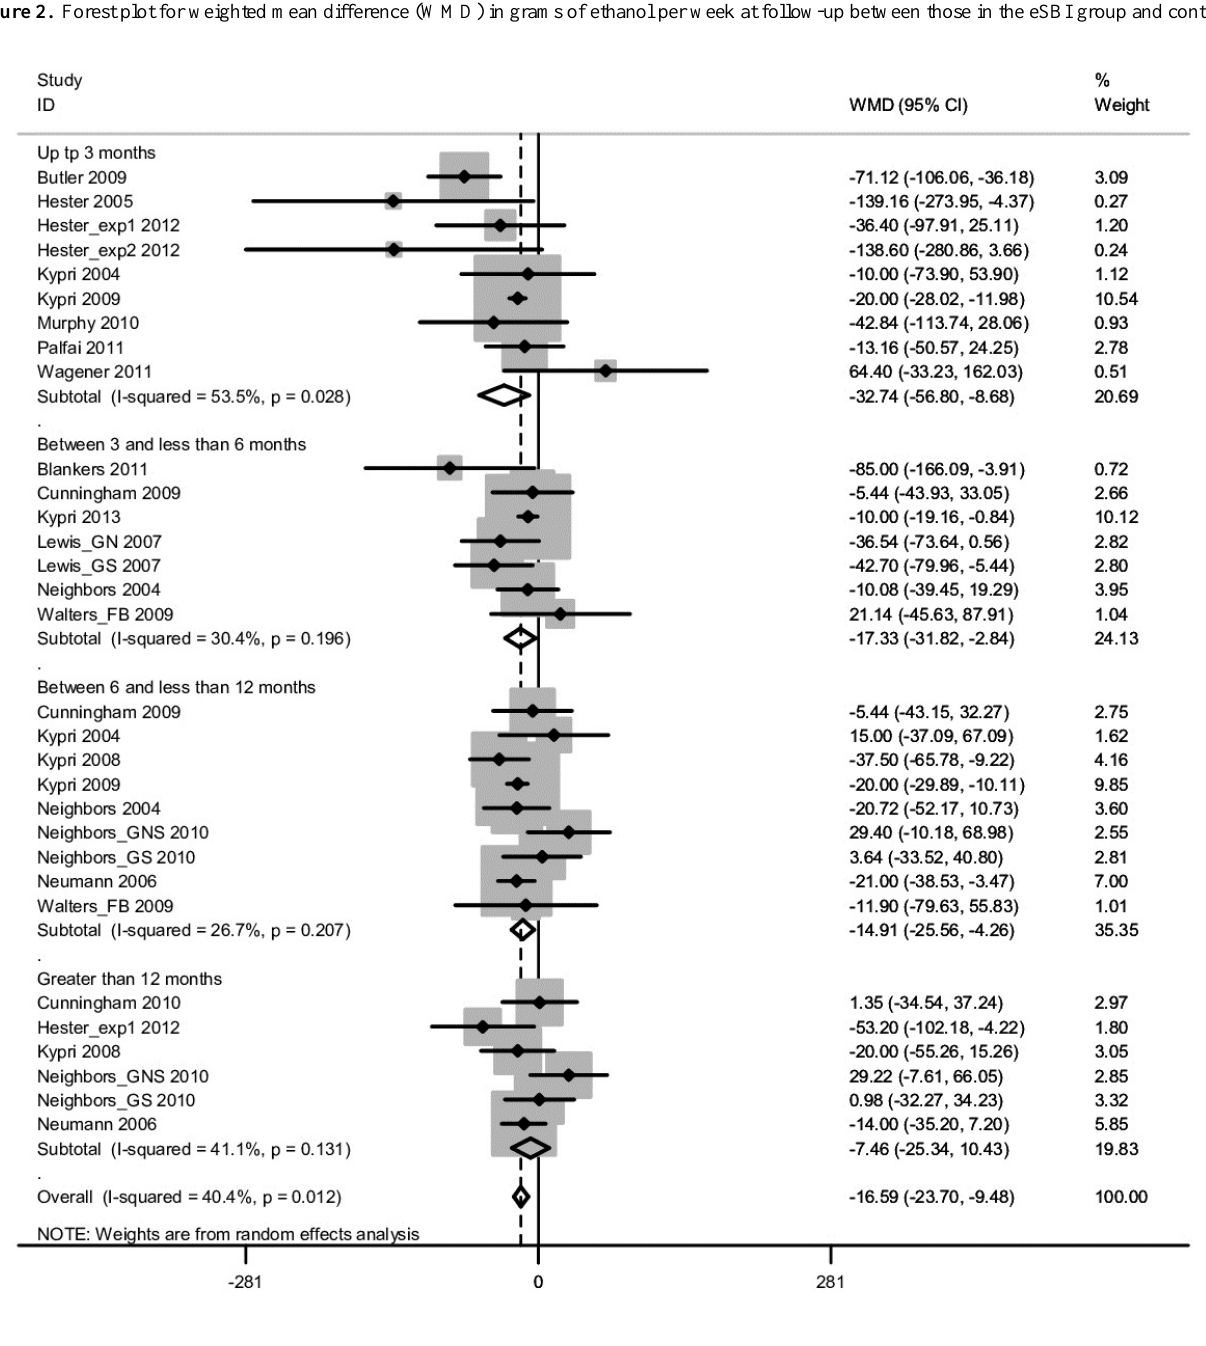
Heterogeneity statisticMean difference